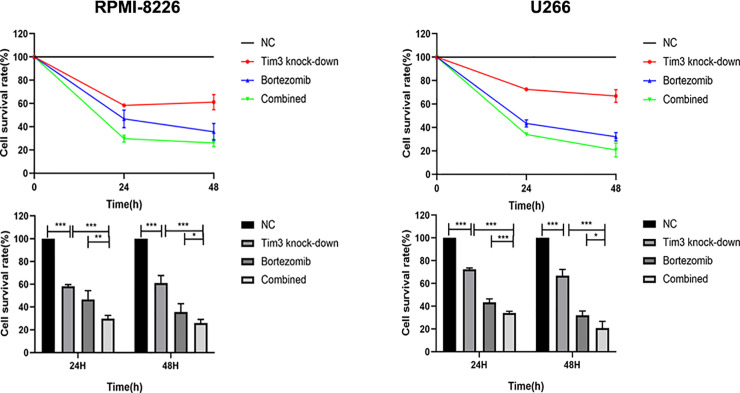
Cell proliferation in the RPMI-8226 and U266 cell lines. Shown are average values with standard deviations. Data are performed from 3 independent experiments. * indicated p<0.05, ** indicated p<0.01 and *** indicated p<0.001.